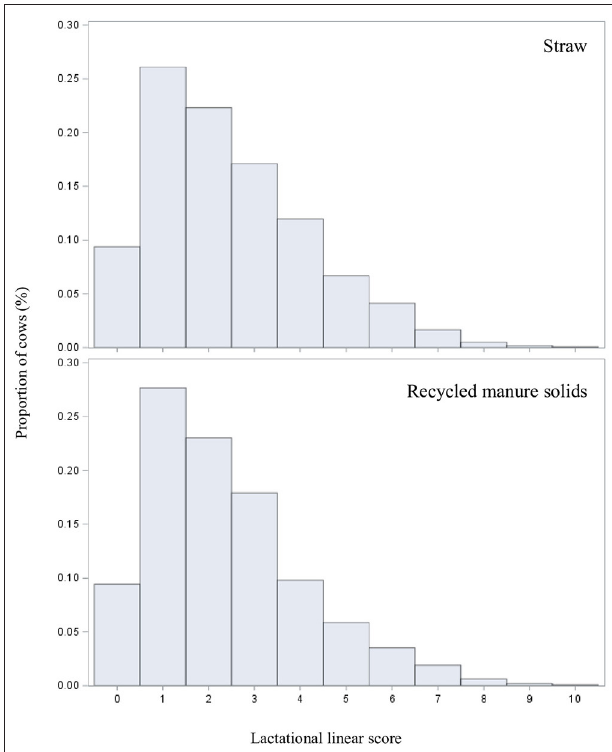
FIGURE 2 | Cow’s mean lactational linear score distributions by bedding type for 15,161 lactations of 11,031 cows from 60 straw-bedded farms (top) and 20 recycled manure solids farms (bottom).